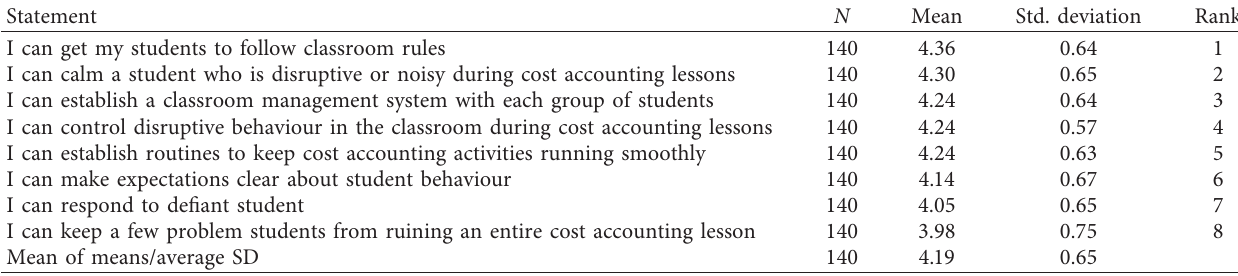
Table 4: Preservice accounting teachers’ self-efficacy in classroom management in teaching cost accounting.